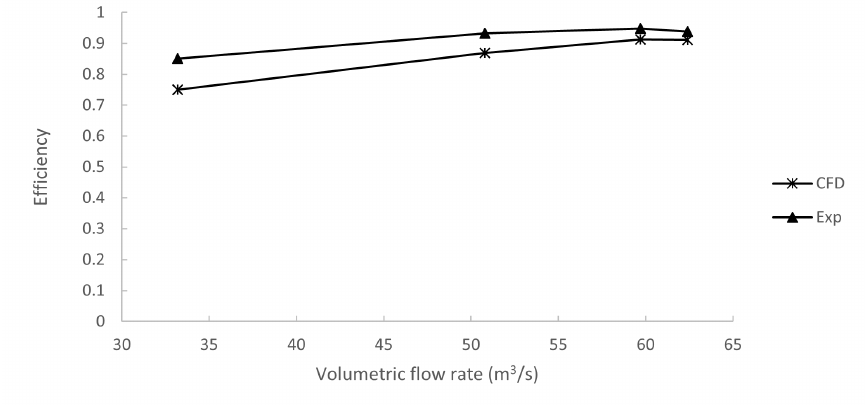
Figure 11. Numerical and experimental efficiency of the